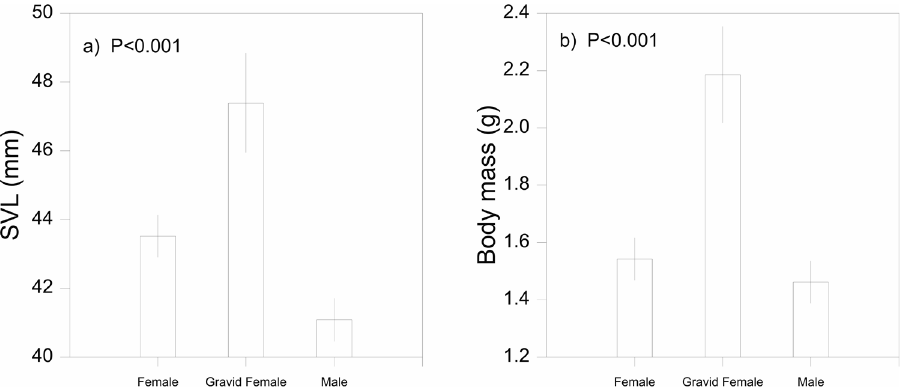
Figure 3. Sexual differences in body size. Regression analysis showing mean values and 95% confidence intervals for: a) snout-vent length (SVL mm), and b) body mass (g) between male, gravid female and non-gravid female Morethia boulengeri in southern New South Wales.